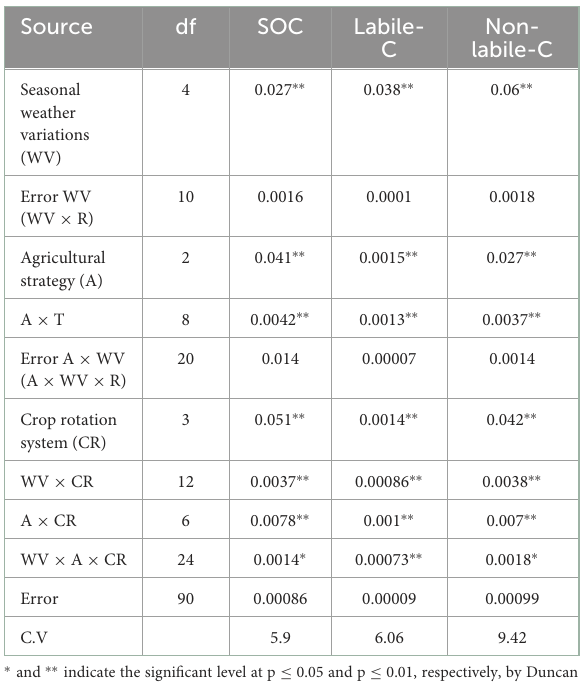
TABLE 3 Results of analysis of variance (ANOVA) and levels of significance for the effect of seasonal weather variations (WV), agricultural strategy (A), crop rotation system (CR) and their interactions on the SOC, labile-C, and non-labile-C during 2018–2020 at the experimental plots near Ahvaz city in Khuzestan province in